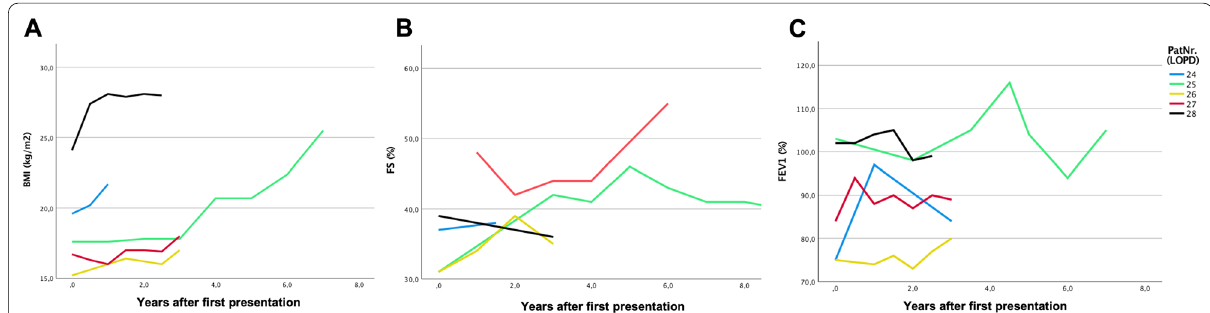
Fig. 3 Exemplary representation of clinical course parameters over time for individual patients with LOPD on enzyme replacement therapy. Shown are the courses from the time of presentation. A ) BMI shows predominantly an increase over time. B ) Fractional shortening (FS) over time. C ) Change in one‑second capacity (FEV1) over